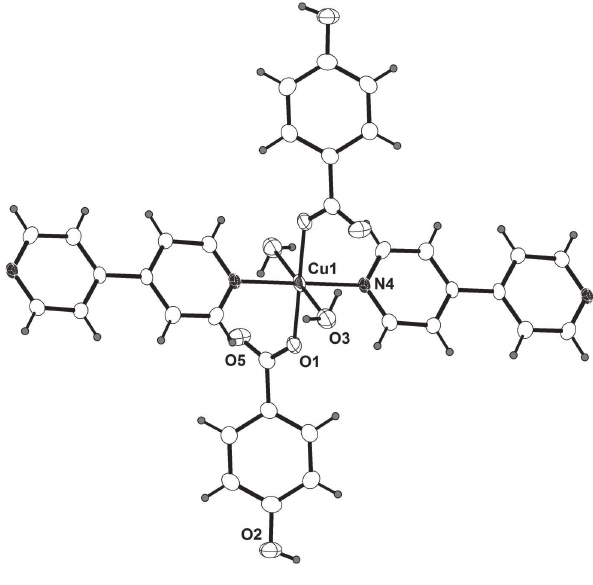
Table 1: Data collection and handling.